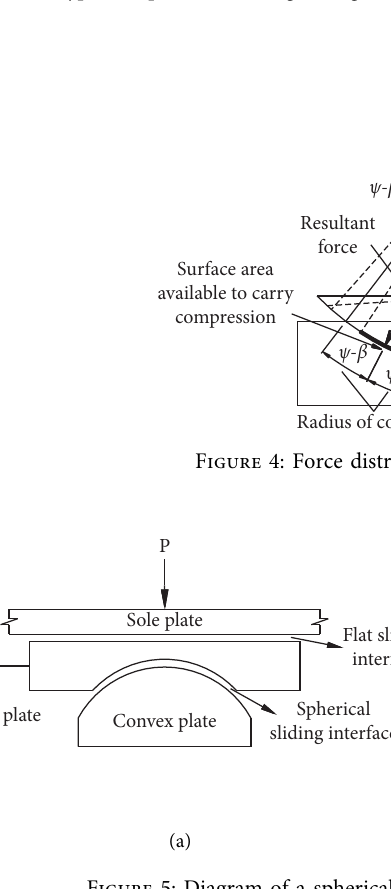
Figure 3: Diferent types of spherical bearings: (a) guided sliding bearing, (b) free sliding bearing, and (c) fxed bearing.